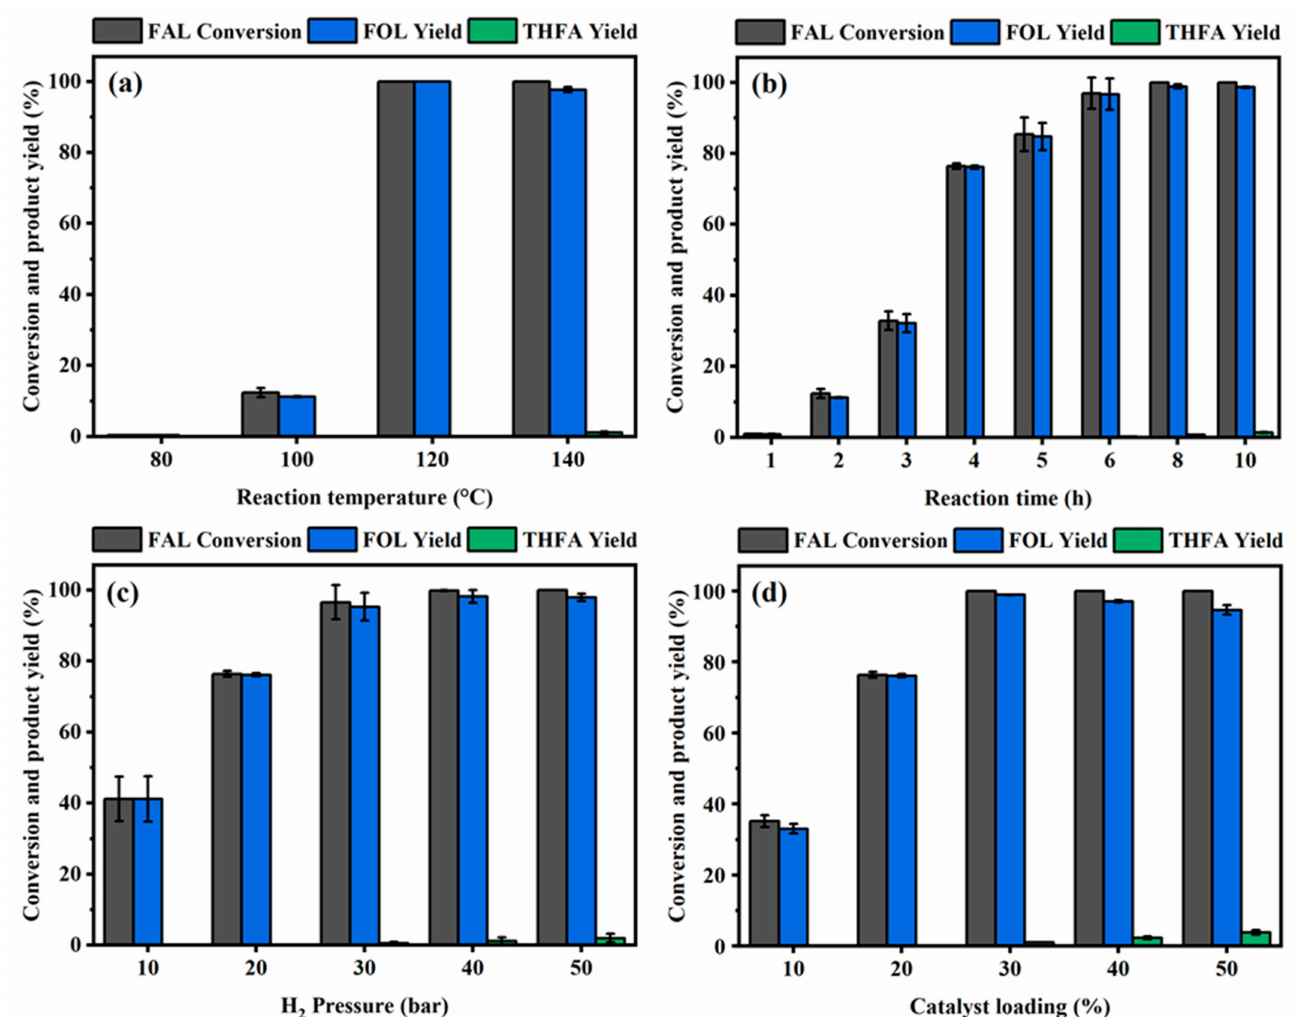
Figure 7. Influences of reaction temperature, reaction time, H 2 pressure, and catalyst loading over Co 1.40 Cu 1 /CaO catalyst: ( a ) reaction conditions: 20% of catalyst loading, 20 bar of H 2 pressure, and time of 2 h; ( b ) reaction conditions: 20% of catalyst loading, 20 bar of H 2 pressure, and 100 ◦ C of temperature; ( c ) reaction conditions: 20% of catalyst loading, 100 ◦ C of temperature, and time of 4 h; and ( d ) reaction conditions: 100 ◦ C of temperature, 20 bar of H 2 pressure, and time of 4 h. All the experiments were conducted using 1 g of FAL feedstock in 40 mL of 2-propanol as an organic